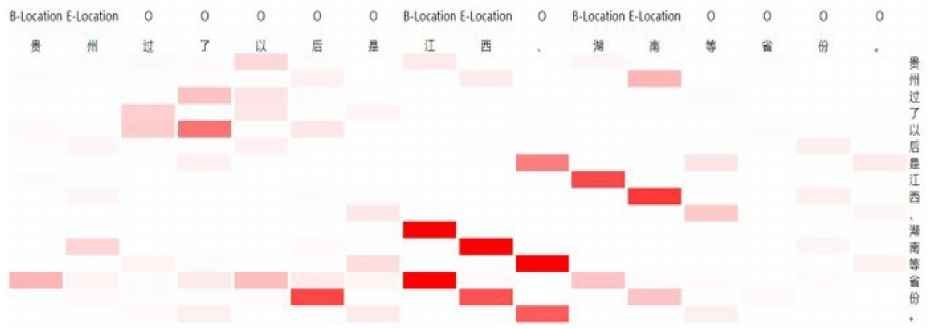
Figure 6. Instance of self-attention visualization